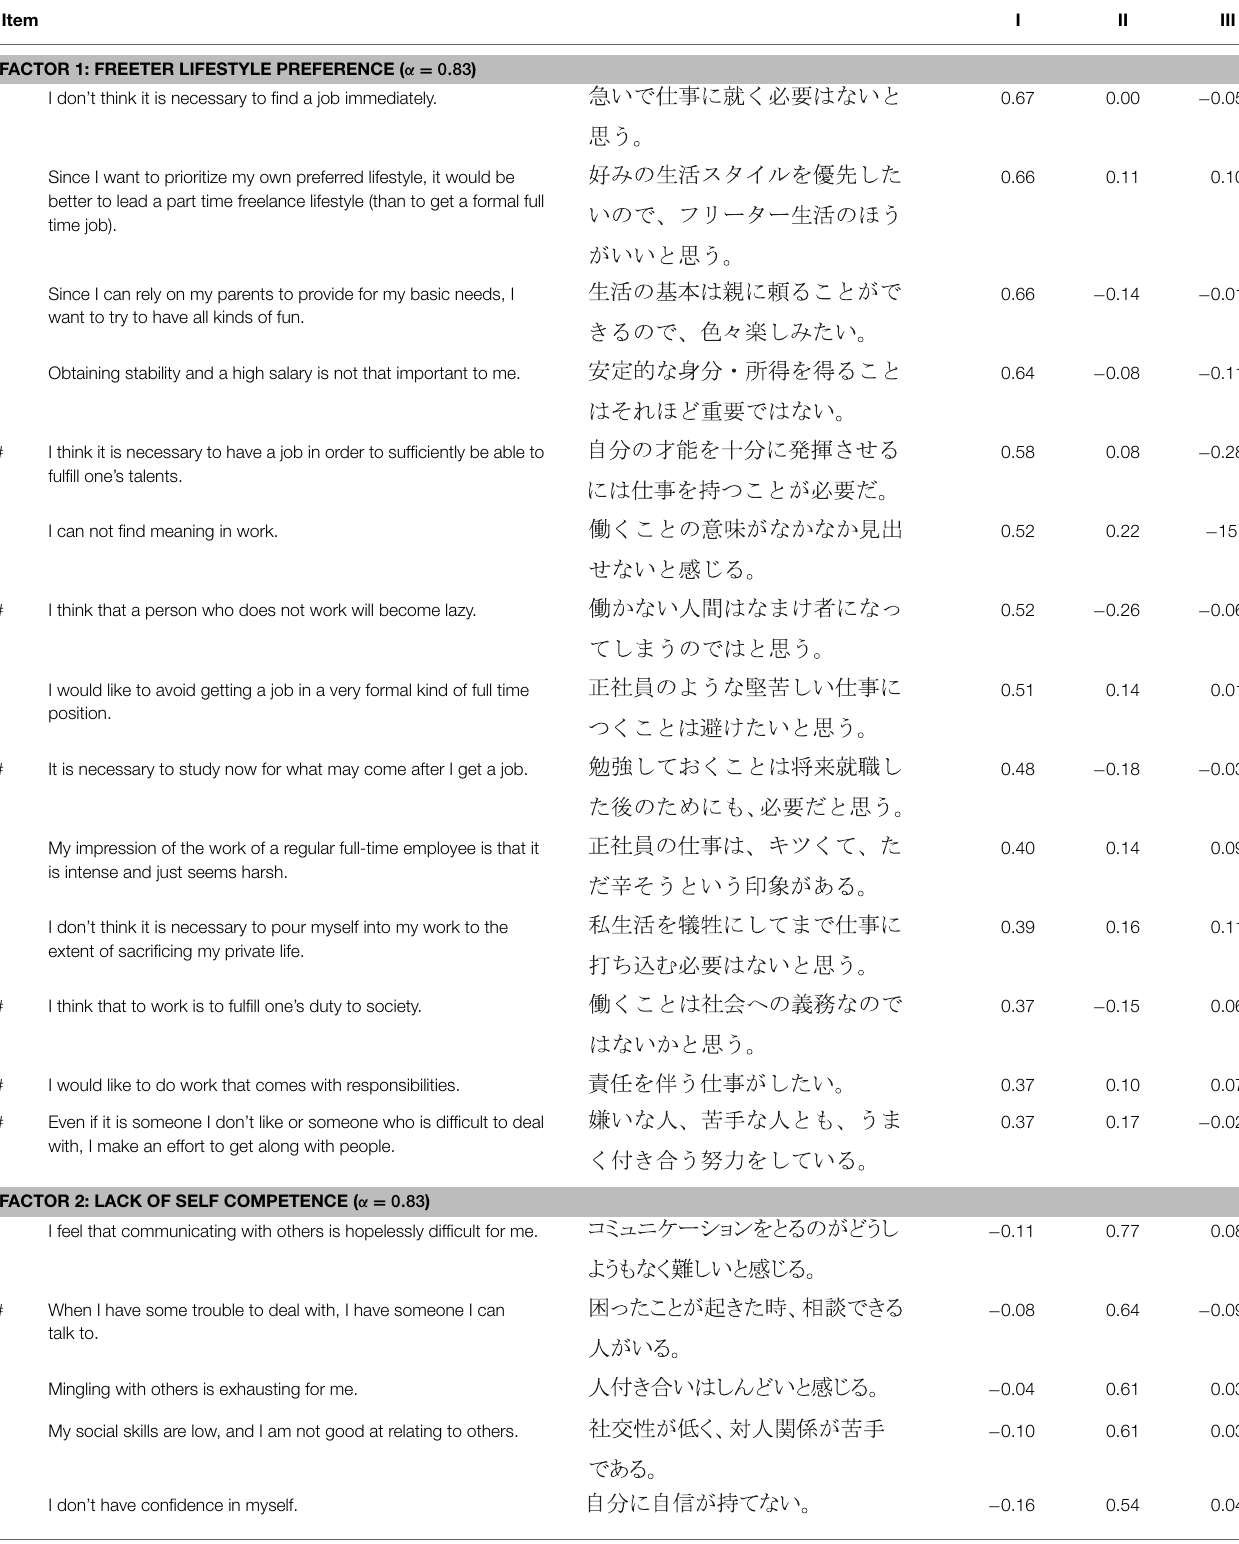
TABLE 1 | NEET Hikikomori Risk (NHR)